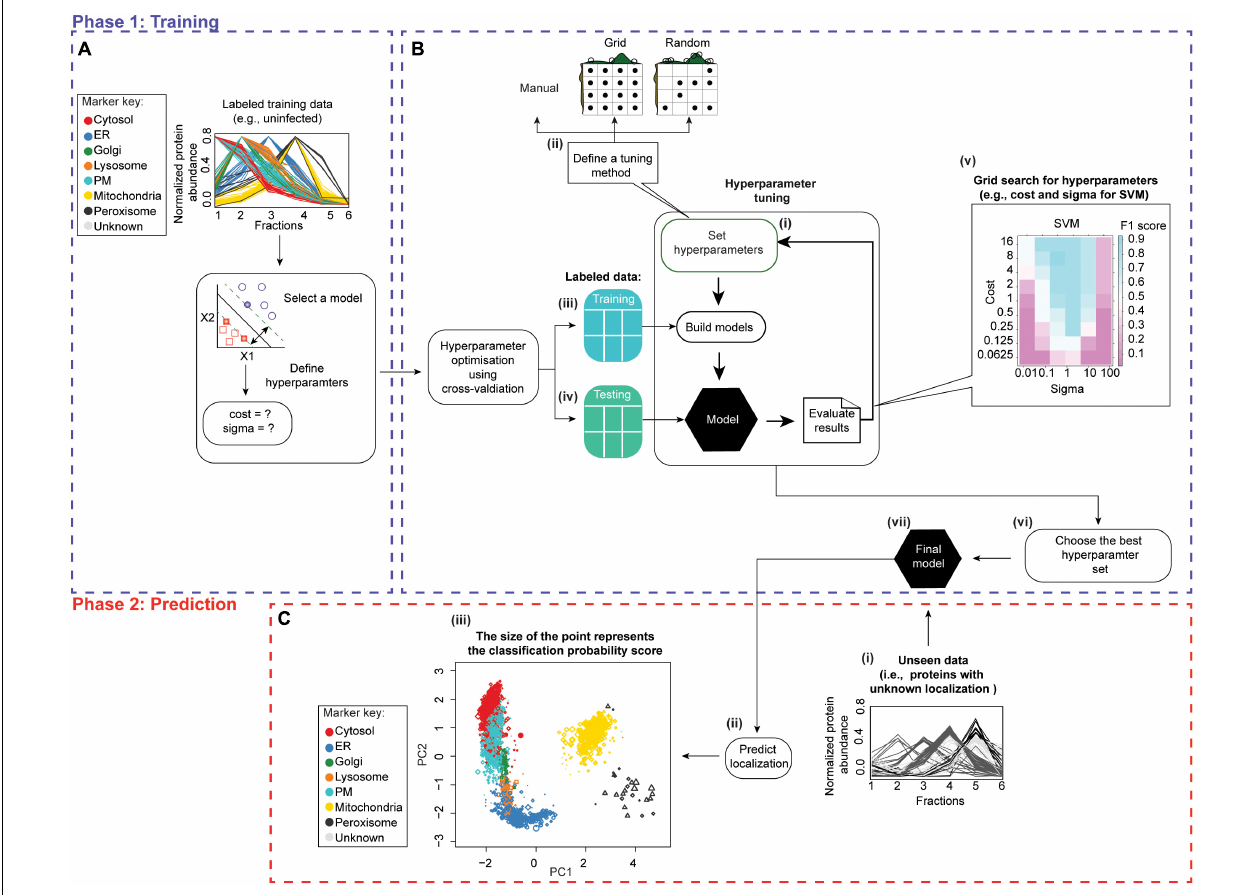
FIGURE 10 | Schematic overview of supervised learning for subcellular localization mapping. (A) The first step in multiclass classification is to select an algorithm with its corresponding hyperparameters. Here, we show SVM. (B) Next, the hyperparameters must be tuned. This includes: (i) defining the range of possible hyperparameter values, (ii) selecting a method for sampling hyperparameter values (i.e., manual, grid, or randomized), and choosing a cross-validation technique (e.g., k -fold) for evaluating the model’s performance with labeled data correspondingly divided into training (iii) and testing (iv) datasets. Moreover, (v) a metric to judge the model’s performance with each set of hyperparameters must be defined. Based on the metric, the best set of hyperparameter values is chosen (vi). For instance, (v) the two SVM hyperparameters (i.e., cost and sigma) were optimized over 50 rounds of 5-fold cross-validation through a grid search, and then the best pair of hyperparameters was chosen based on the evaluation of F1 score. Once the best combination of hyperparameters has been selected (vi), it can be used to build the final model (vii). (C) Proteins with unknown localizations are then presented to the model (i), and the model predicts their labels (i.e., localizations; ii). (iii) Classification scores for unlabeled instances that correspond to their most likely subcellular compartment are reflected by point sizes. Each point here represents a protein. Uninfected data from Figure 7 was used throughout this figure. The same workflow can also be applied to the infected